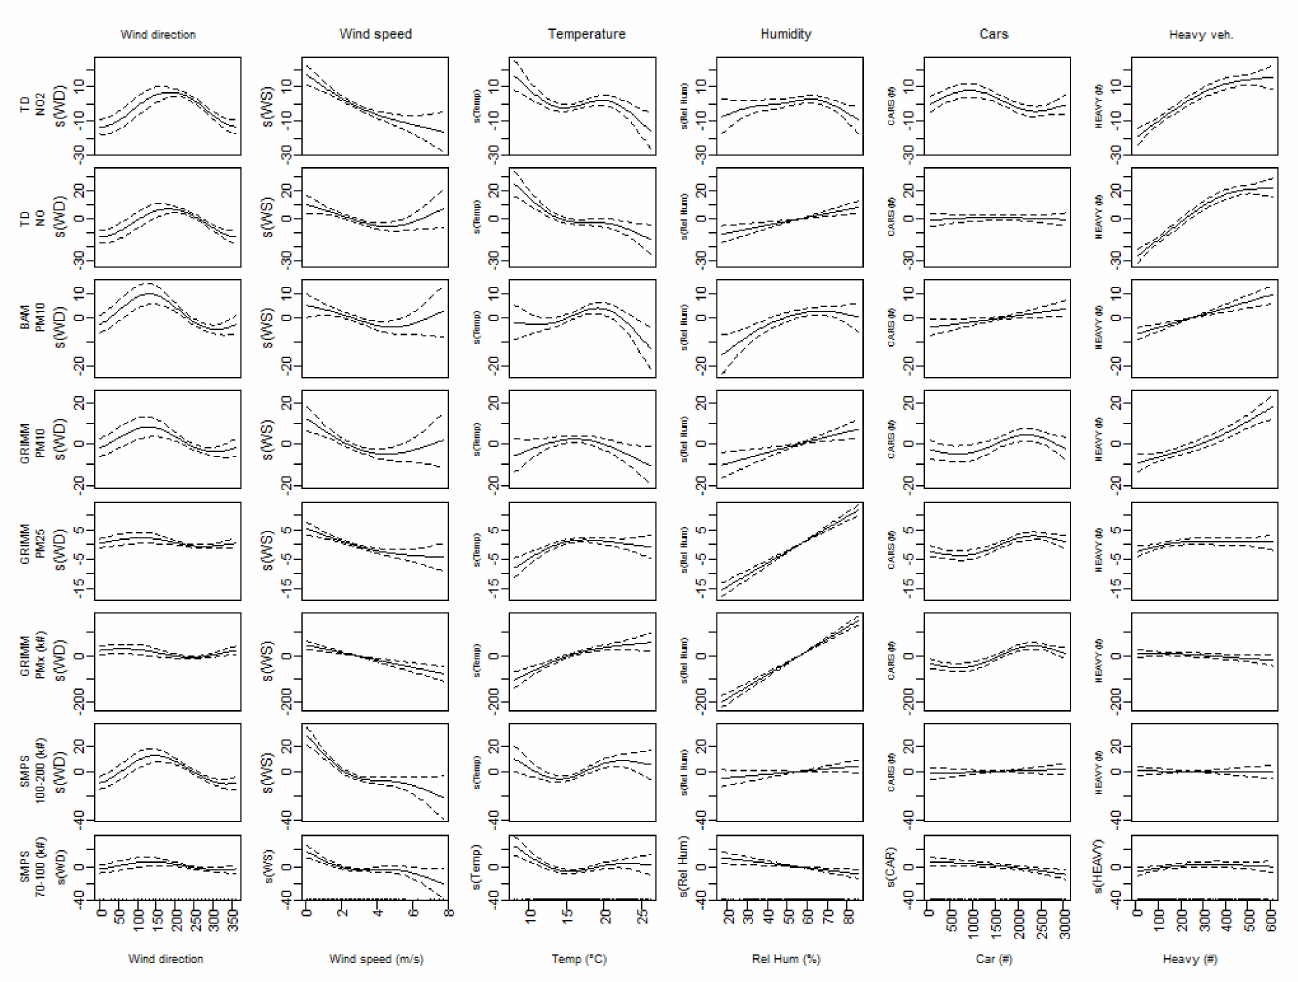
Figure 7. Selection of the extended traffic-air pollution GAM models that include temperature and relative humidity: NO 2 , NO, PM10 (BAM); PM10, PM2.5 and PMx (GRIMM); UFP count 100–200 nm and 70–100 nm